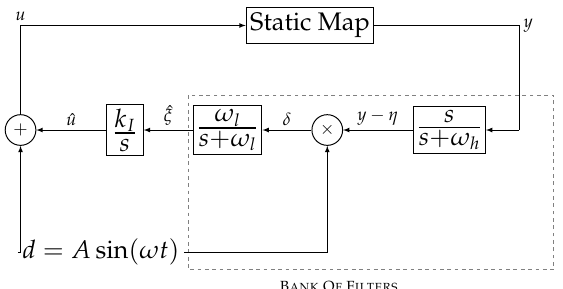
Figure 2. Extremum seeking with bank of